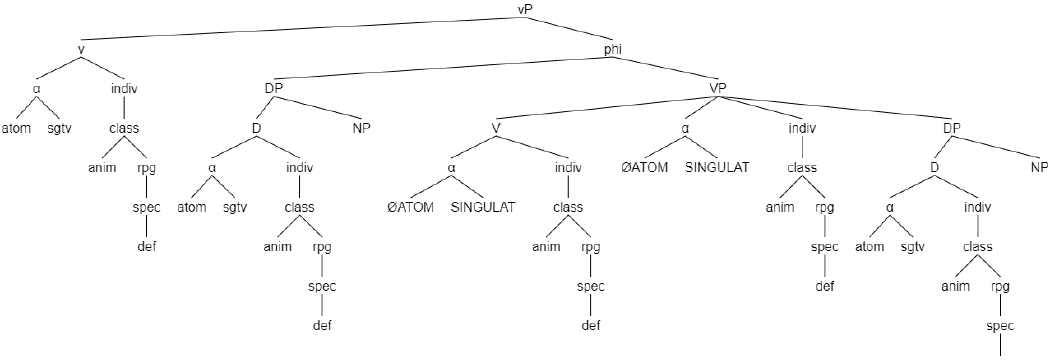
Figure 27. After insertion of v*, inheritance, Agree, and labeling.